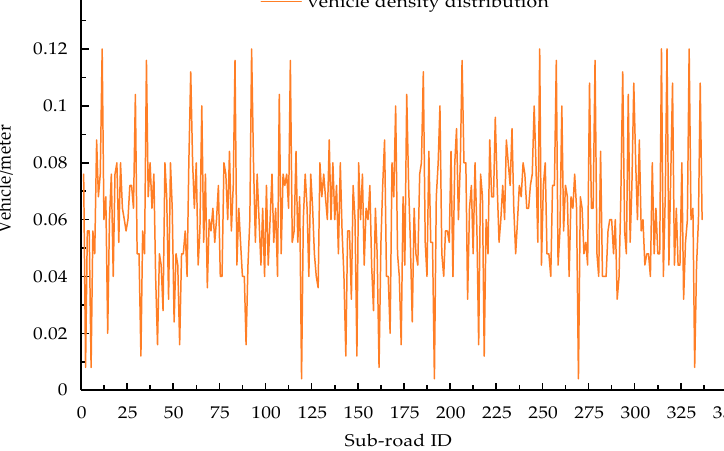
Figure 3. Vehicle density distribution in synthetic simulation.